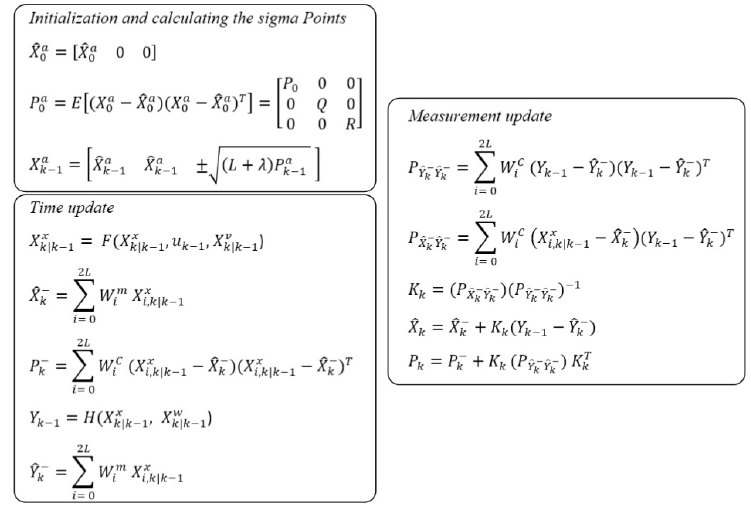
Figure 6. Unscented Kalman filter (UKF) algorithm equations.